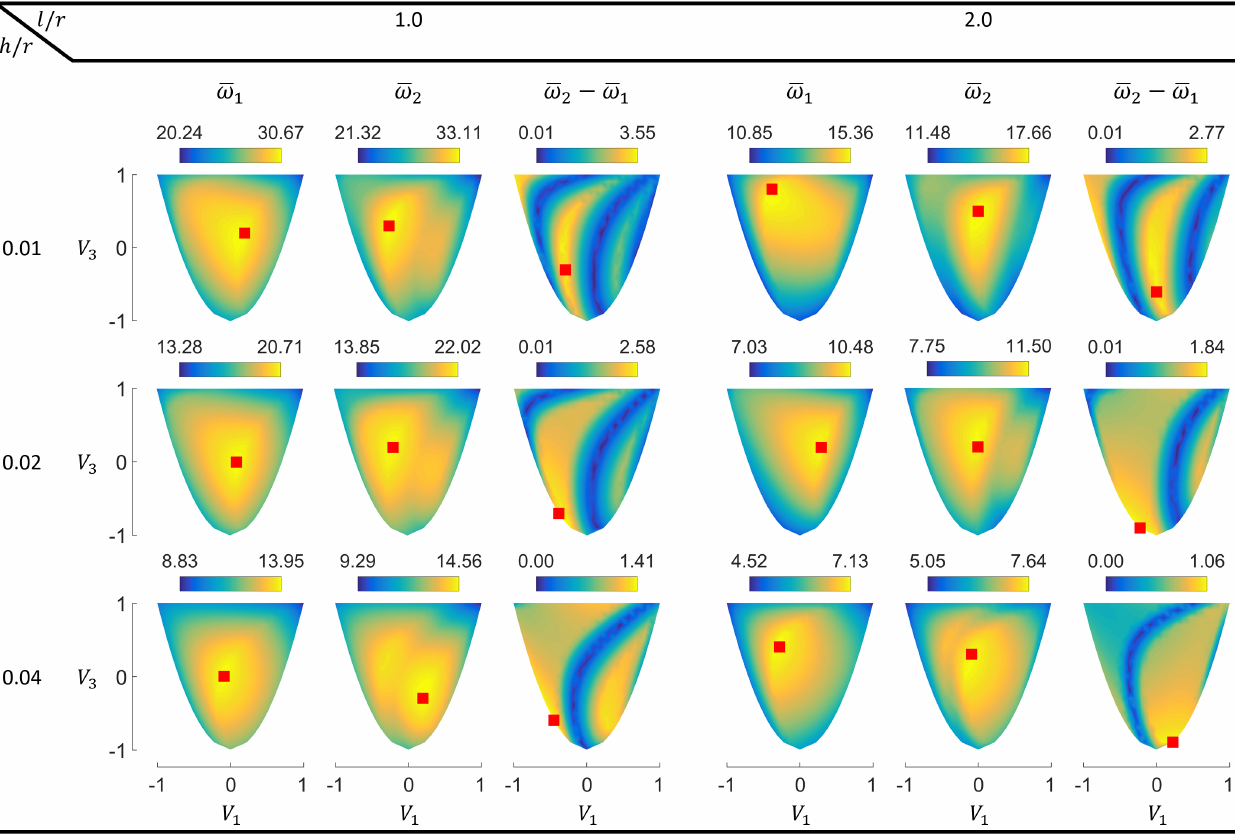
Figure 4. Lamination parameter plane contours of the first two normalized eigenfrequencies and their differences for cantilever circular composite